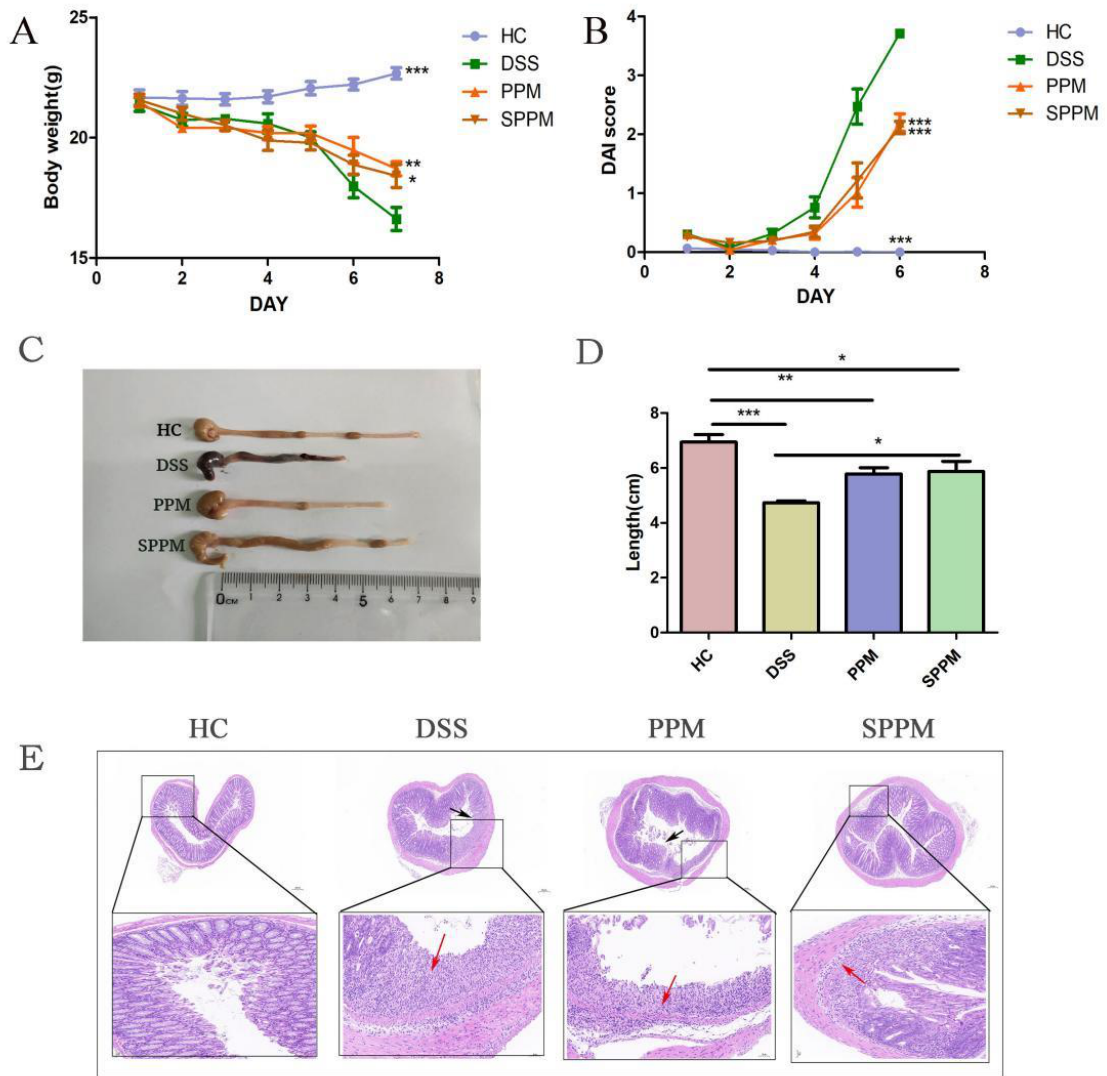
Figure 2. PPM60-III and SPPM60-III reduced inflammation in mice. ( A ) Body weight; ( B ) DAI score; ( C ) comparison of colonic length in mice; ( D ) length of mouse colon; and ( E ) HE staining of colon. Black arrows show shedding of epithelial cells and red arrows show infiltrating of inflammatory cells. * p < 0.05, ** p < 0.01, *** p <